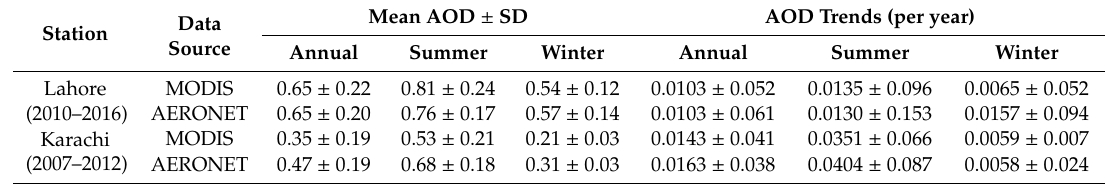
Table 3. Multiyear annual and seasonal mean AOD with standard deviation (SD); Seasonal and annual AOD trends (per year) for the two stations; based on MODIS-Terra DB as well as AERONET AOD data